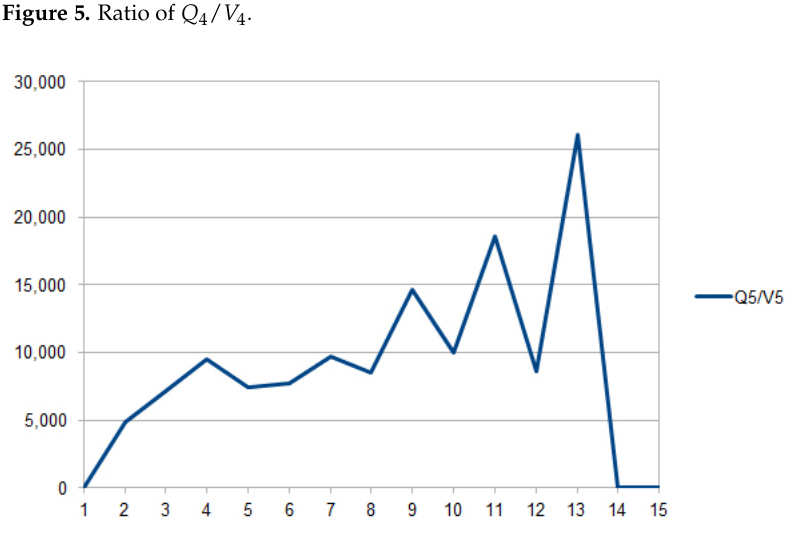
Figure 6. Ratio of Q 5 / V 5